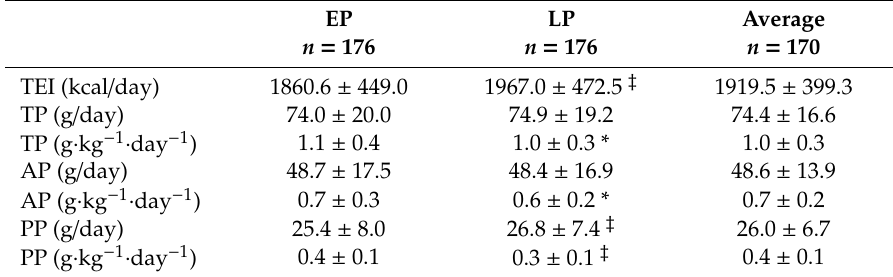
Table 2. Dietary Protein Intake during Early Pregnancy (EP), Late Pregnancy (LP), and Average Protein Intake throughout